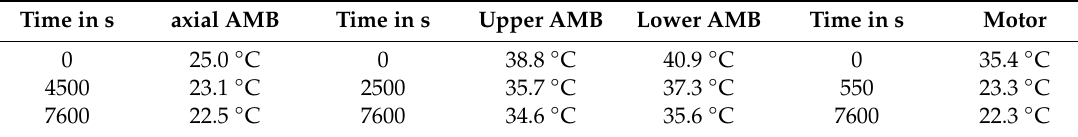
Table A1. Measured stator temperature during cool down.